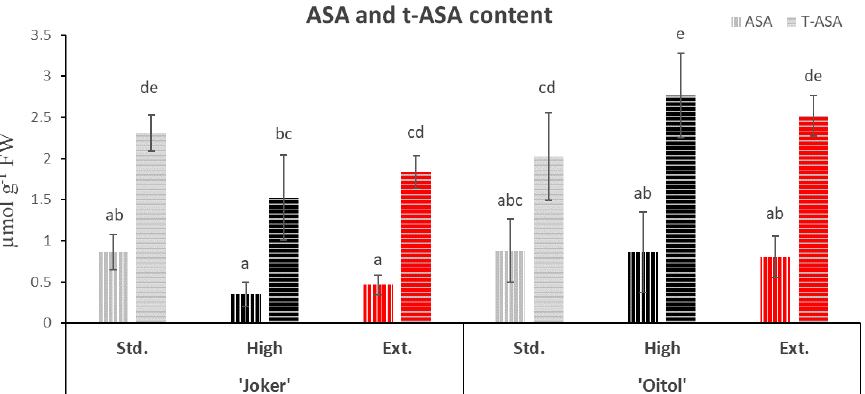
Figure 2. Tissue concentrations of reduced (AsA) and total ascorbic acid (t-AsA) in the leaves of two F1 cucumber hybrid lines treated with different nitrate concentrations. Std.: 4 mM, High: 20 mM and Ext.: 50 mM KNO 3 . Different letters are for significant differences ( p < 0.05). Data are the means of at least six replicates, with error bars representing standard deviations.